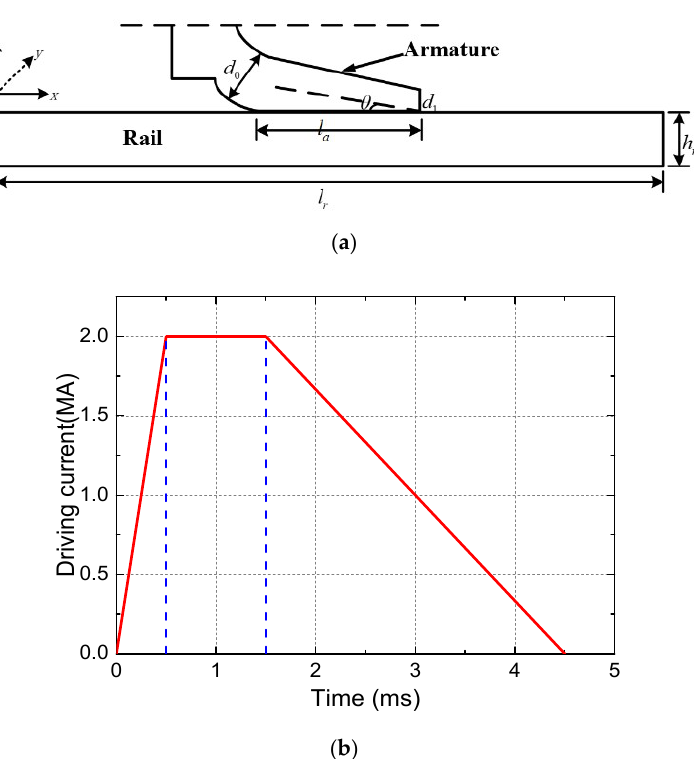
Figure 6. Geometry of A/R system and driving current: ( a ) two-dimensional schematic diagram of the A/R system, ( b ) driving current.